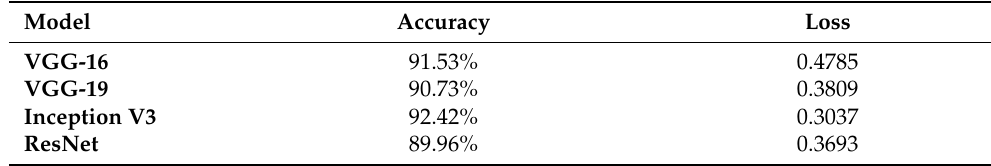
Table 5. A comparison between the proposed TL